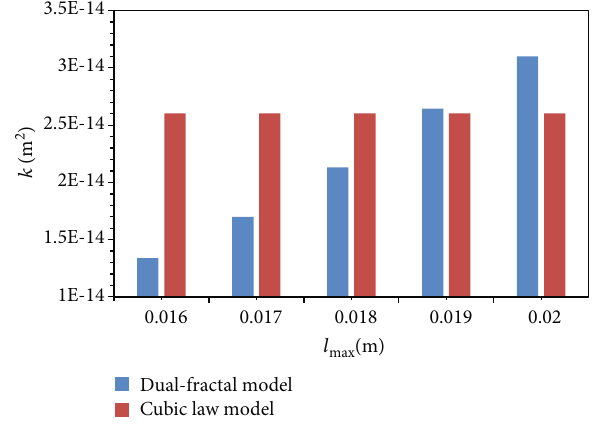
of fracture length. f